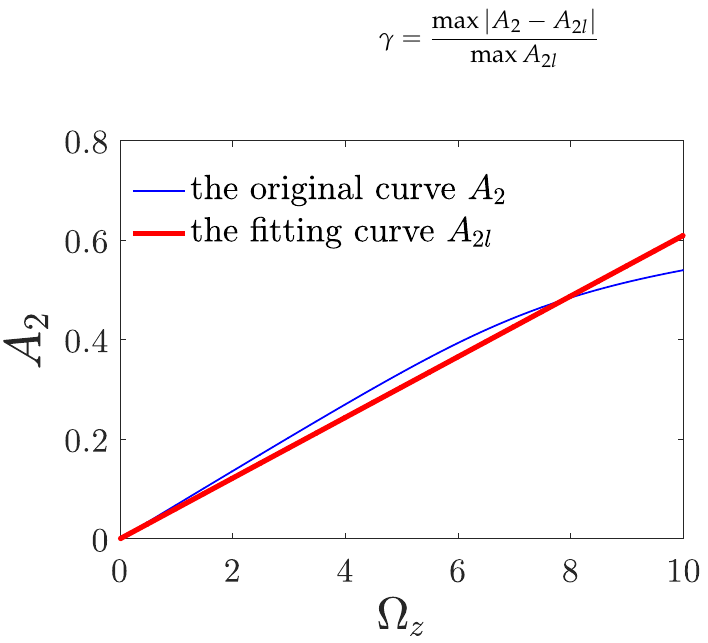
13 Figure 13. Least-square fitting of the influence curve of the angular velocity; E X = 25, E Y = 30.